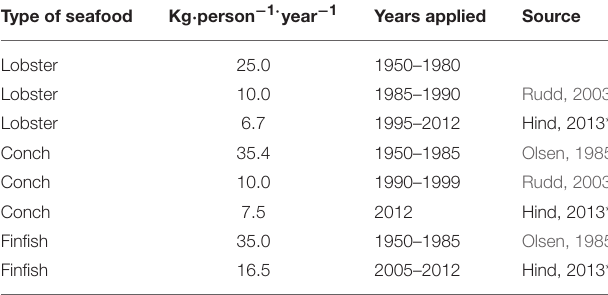
TABLE 3 | Per capita seafood consumption used for domestic consumption, years applied and sources used. Type of seafood